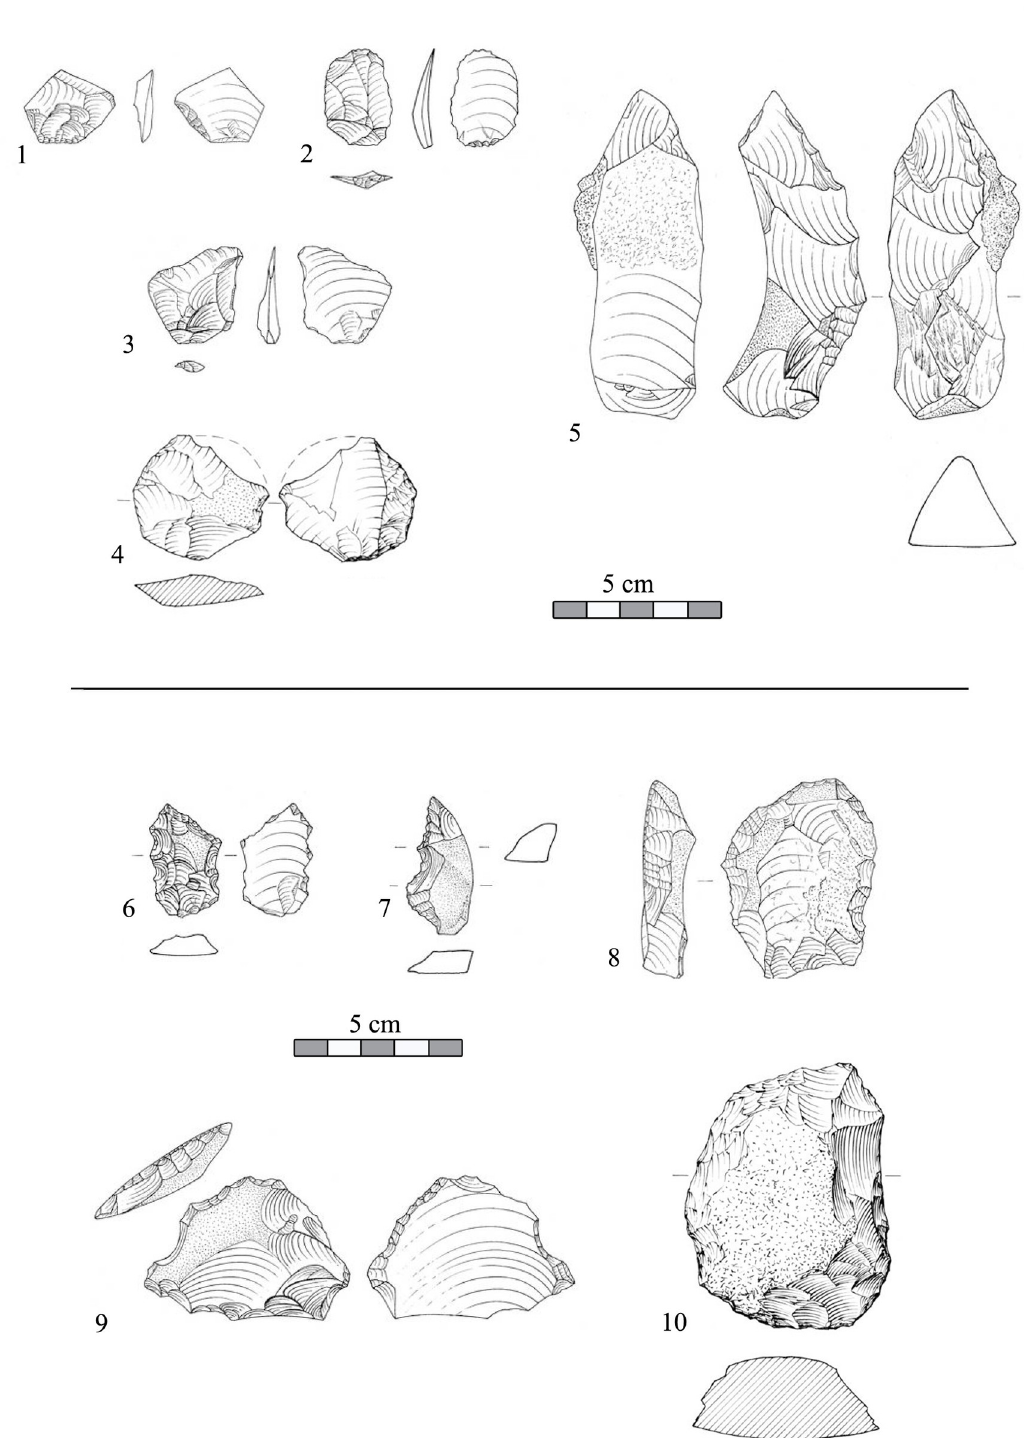
Fig 11. Special spalls and shaped items from the assemblage of Area B in Jaljulia. 1–5) Bifacial shaping spalls. 6–9) Denticulated flakes. 10) Scraper.